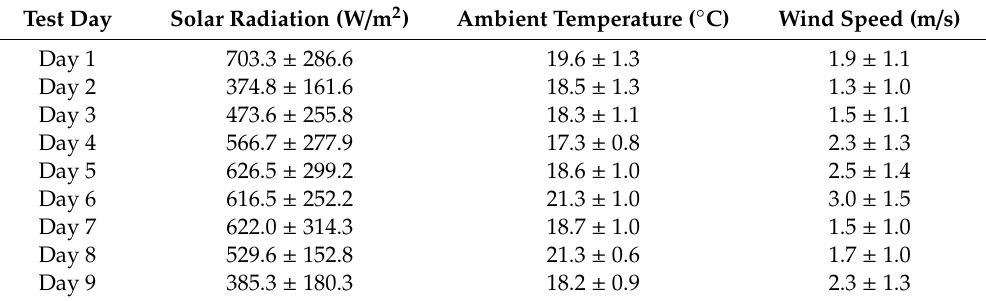
Table 4. Mean (± standard deviation) values of the global horizontal solar radiation, ambient Table 4. Mean ( ± standard deviation) values of the global horizontal solar radiation, ambient temperature and wind speed on each test day. temperature and wind speed on each test